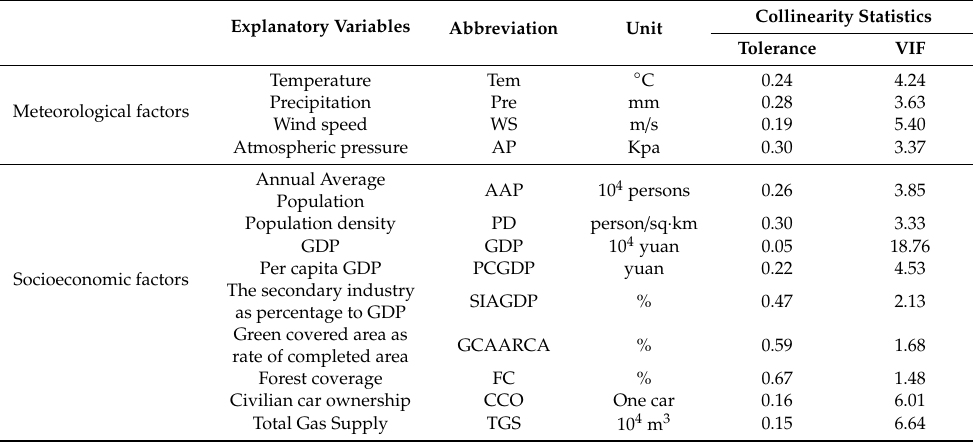
Figure 1. Distribution of air quality monitoring stations in the study area. Inset map shows the location of the study area in China. Table 2. Description of explanatory variables of the AQI and collinearity